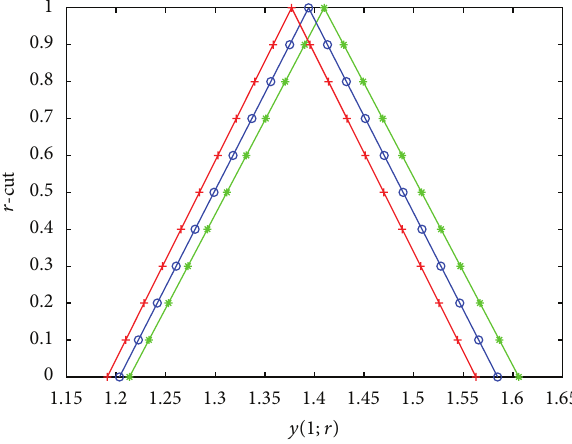
Figure 9: The approximate solution for 𝛼 = 0.75(∗) , 0.85(∘) , and 0.95(+) of Example 57, 𝑚 = 8